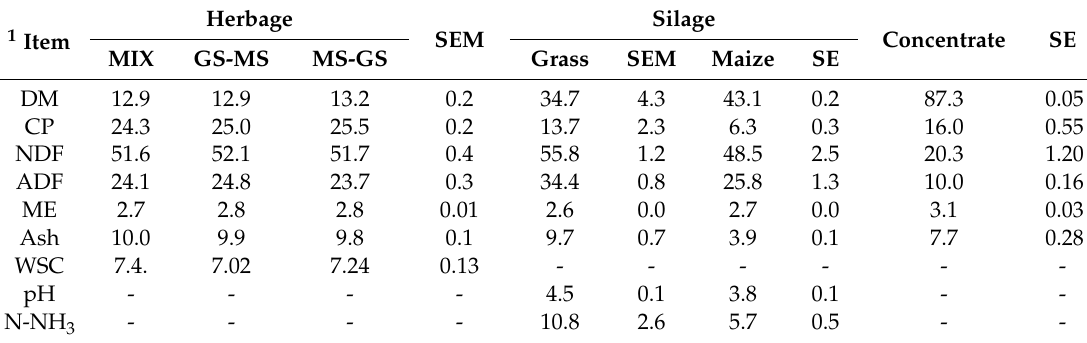
Table 1. Chemical composition of herbage and supplements o ff ered to grazing dairy cows supplemented with 50:50 grass and maize silage in the morning and afternoon (MIX), grass silage in the morning and maize silage in the afternoon (GS-MS) or maize silage in the morning and grass silage in the afternoon (MS-GS).